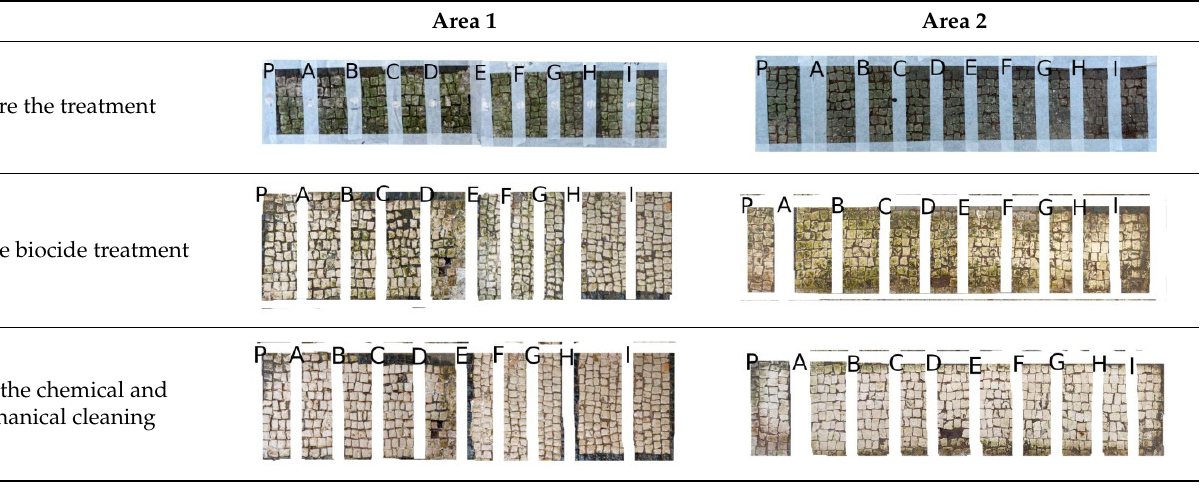
Table 3. Images of Areas 1 and 2 before, after the treatment with Eos, and after the cleaning procedure.